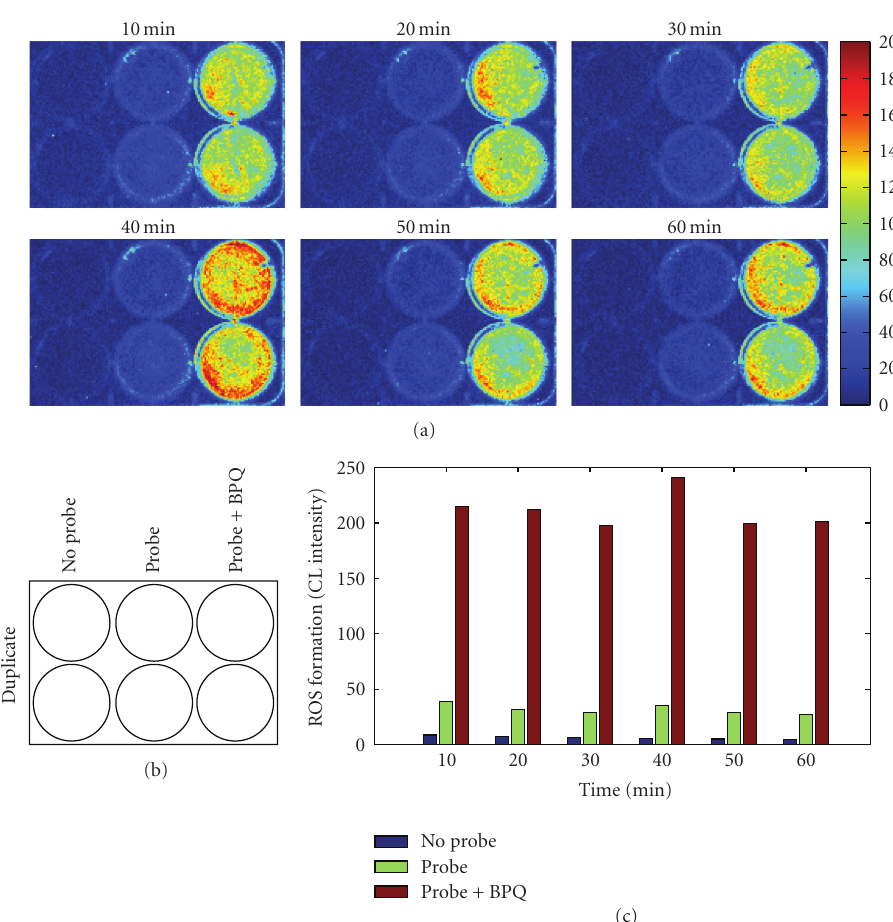
Figure 2: In situ real-time CL imaging of basal and BPQ-stimulated ROS formation in cultured monolayers of H9c2 cardiomyocytes. H9c2 cells were cultured in 6-well plates. Immediately prior to CL imaging, confluent cells in culture were washed once with PBS followed by addition of 2mL PBS containing 1 μ M BPQ or other reagents, as described under Materials and Methods section. (a) Representative CL images acquired at the indicated time points; the images for the first 10 minutes were acquired with a 5-minute delay; (b) layout of treatment groups; probe refers to luminol/HRP; (c) quantification of time-dependent ROS formation by luminol/HRP-amplified CL imaging. Data in (c) represent averages of two